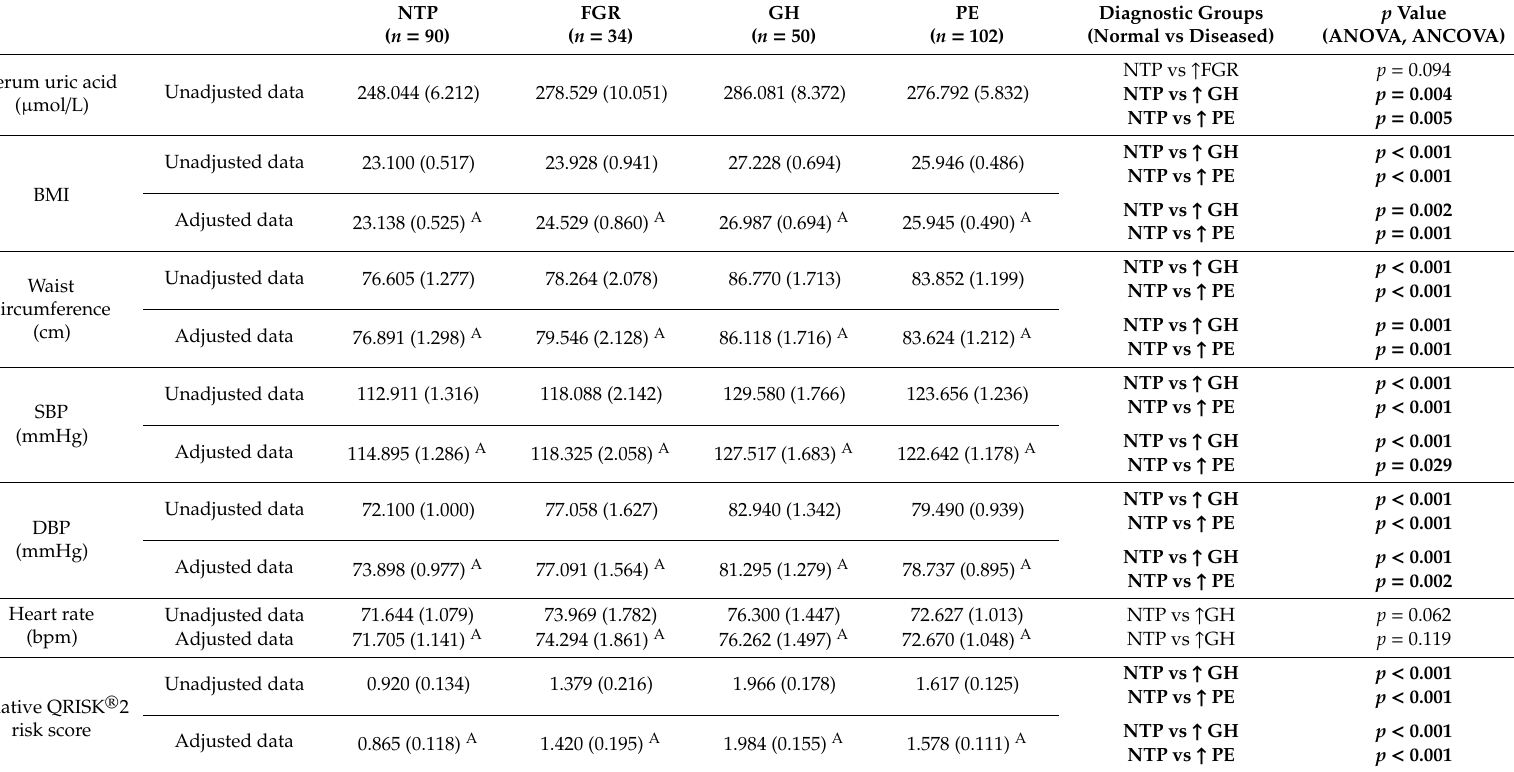
Table 2. Impact of GH or PE history on maternal cardiovascular risk-overview (ANOVA and ANCOVA